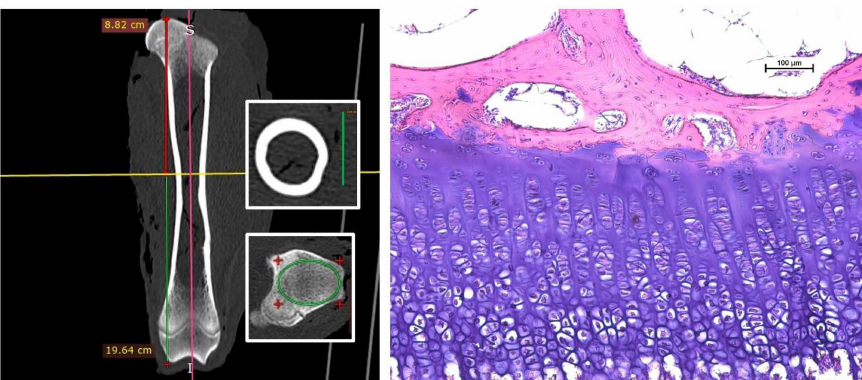
Figure 1. Representative images of macro- and microstructure of a ram’s femur at 12 months. ( left ) A CT image showing femur geometry. The longitudinal image shows femur length measurements; the insets show cross-sectional images of the diaphysis (upper inset) and epiphysis (lower inset) used for cortical and trabecular parameter analysis. ( right ) A photomicrograph used for histomorphometric analysis of the structure and zones of the distal epiphyseal growth plate (EGP), hematoxylin and eosin staining, scale bar = 100 µ m. RZ—zone of reserve cartilage, PZ—zone of proliferation, HZ—zone of hypertrophy, CZ—zone of calcified